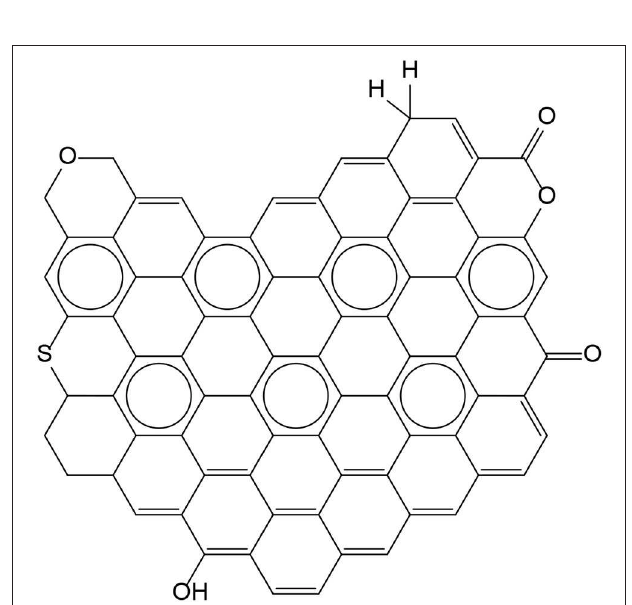
FIGURE 7 | Possible chemical functionalities of carbon black surface.